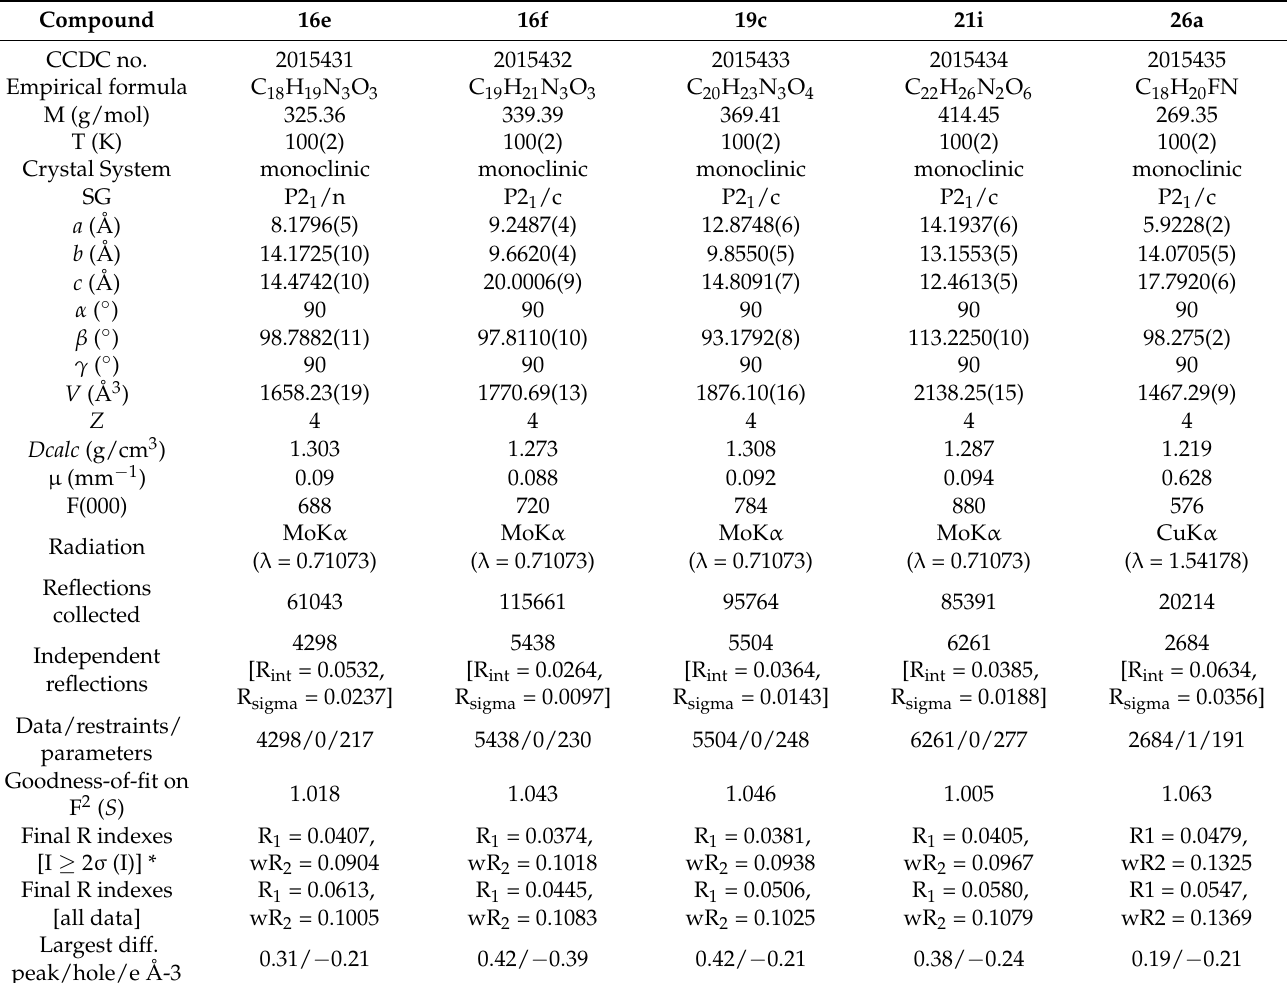
Table 1. Crystal data and structure refinement details for compounds 16e , 16f , 19c , 21i , and 26a